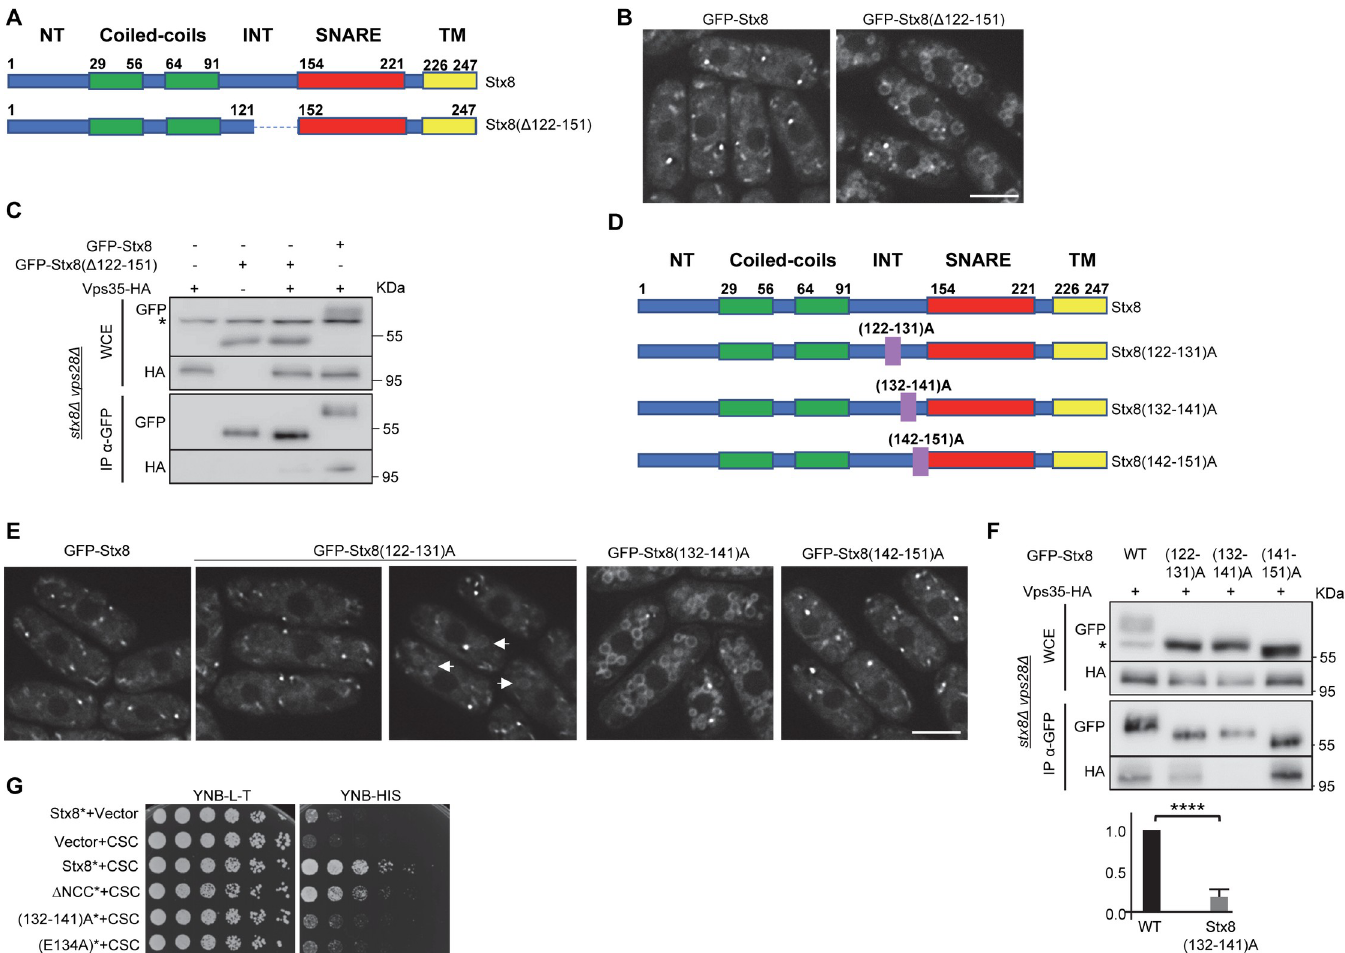
Fig 5. Residues at positions 132–141 are required for Stx8 recycling by retromer. (A) Schematic, not-to-scale representation of Stx8 and Stx8( Δ 122–151). Bold numbers denote the initial and terminal amino acid position of the regions of interest. The dashed line represents the protein region deleted. (B) Localization of the indicated proteins. (C) Coimmunoprecipitation between Stx8( Δ 122–152) and Vps35. As a control, the interaction between Stx8 and Vps35 was included (lanes on the right). Cell extracts from stx8 Δ vps28 Δ strains carrying GFP-Stx8, GFP-Stx8( Δ 122–152) and/or Vps35-HA were analyzed by western blot using anti-GFP or anti-HA monoclonal antibodies before (WCE, whole-cell extracts) or after immunoprecipitation (IP) with a monoclonal anti-GFP antibody. The asterisk denotes a nonspecific band. (D) Schematic, not-to-scale representation of the indicated Stx8 variants. The numbers in parentheses indicate the residues that were mutated to alanine, and the purple rectangles indicate their relative position in the protein. (E) Localization of the indicated Stx8 variants. Arrows denote vacuoles with mild fluorescence at their surface. (F) The same details as in C, but coimmunoprecipitation between the indicated GFP-Stx8 variants and Vps35-HA was analyzed. The amount of Vps35-HA that coimmunoprecipitated with GFP-Stx8 (WT) and GFP-Stx8(132–142)A proteins was estimated and quantified (see Materials and methods). The statistical significance of the differences is shown in the lowest panel (t- test; ���� , p < 0,0001). G. Serial dilutions of the Saccharomyces cerevisiae AH109 host strain transformed with empty plasmids (vector) and/or with plasmids expressing Stx8 � (Stx8 lacking the TM helix), the indicated Stx8 � variants and/or a fusion Vps29-Vps35-Vps26 protein (CSC) were spotted on yeast nitrogen base medium without leucine and tryptophan (YNB-L-T) and without histidine (YNB-H) and incubated at 30˚C for four days. Growth on YNB-H shows direct interaction between Stx8 � and CSC. In B and E, images are single planes captured with a DeltaVision system. Scale bar, 5 μ m.